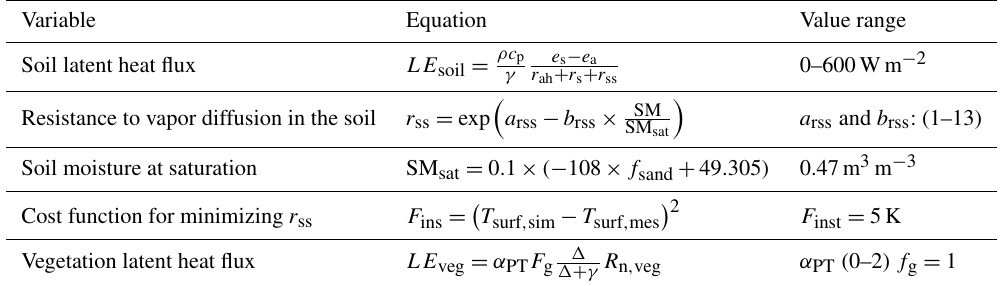
Table 2. Mean equations of